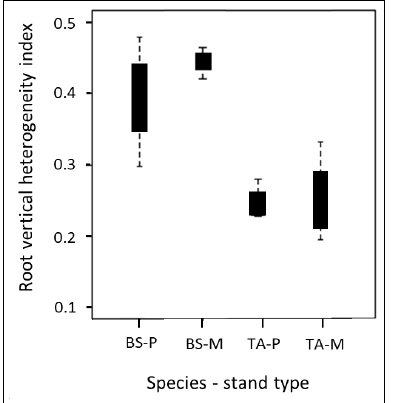
Figure 3. Fine roots vertical heterogeneity index describing how fully and evenly fine roots of black spruce (BS) and trembling aspen (TA) are distributed with soil depth in pure (P) and mixed (M) stands.